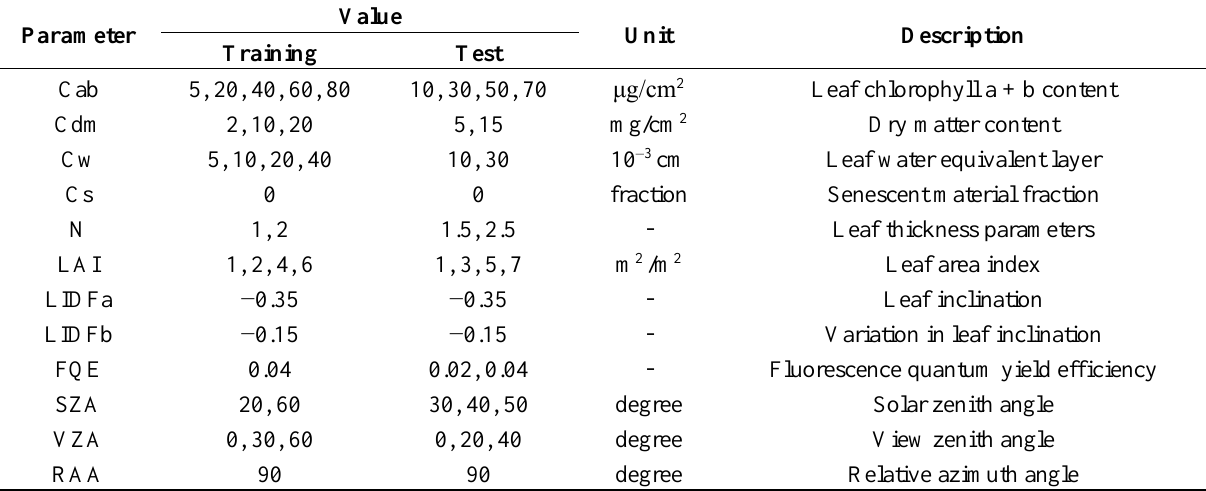
Table 1. Input leaf and canopy parameters used in the Soil Canopy Observation, Photochemistry and Energy fluxes (SCOPE) model for the simulation of the training